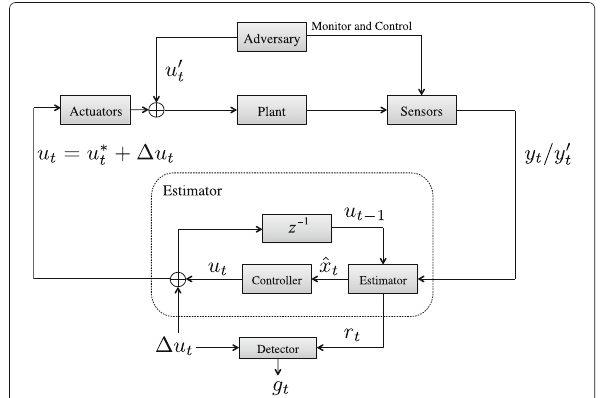
Fig. 2 Overall control system equipped with the watermark-based detection scheme in [4,